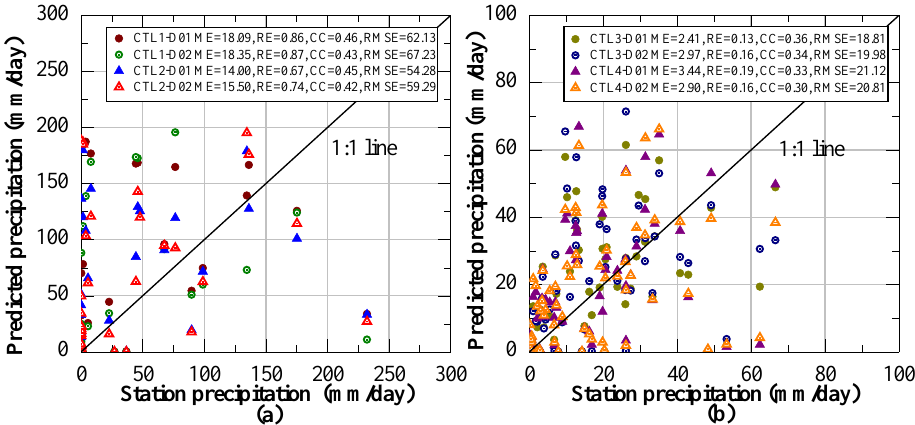
Figure 3. Scatter plots of daily precipitation (mm/day) observed by the China Meteorological Administration (CMA) meteorological stations and predicted by the WRF control experiments: CTL1 and CTL2 ( a ) and CTL3 and CTL4 ( b ).